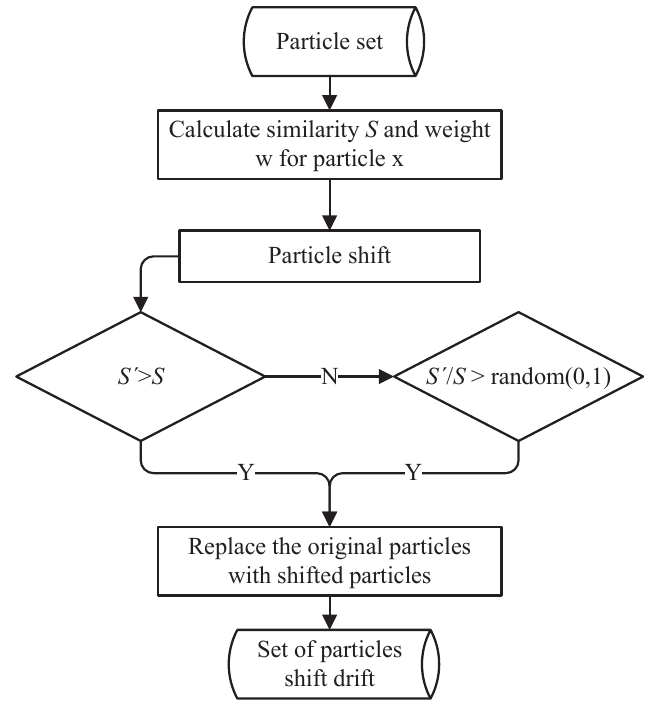
Figure 2. The particle selection